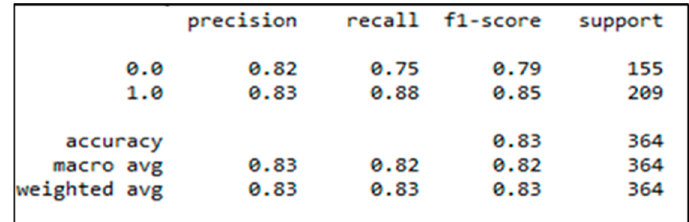
Figure 3. Classification matrix for the emotion module.